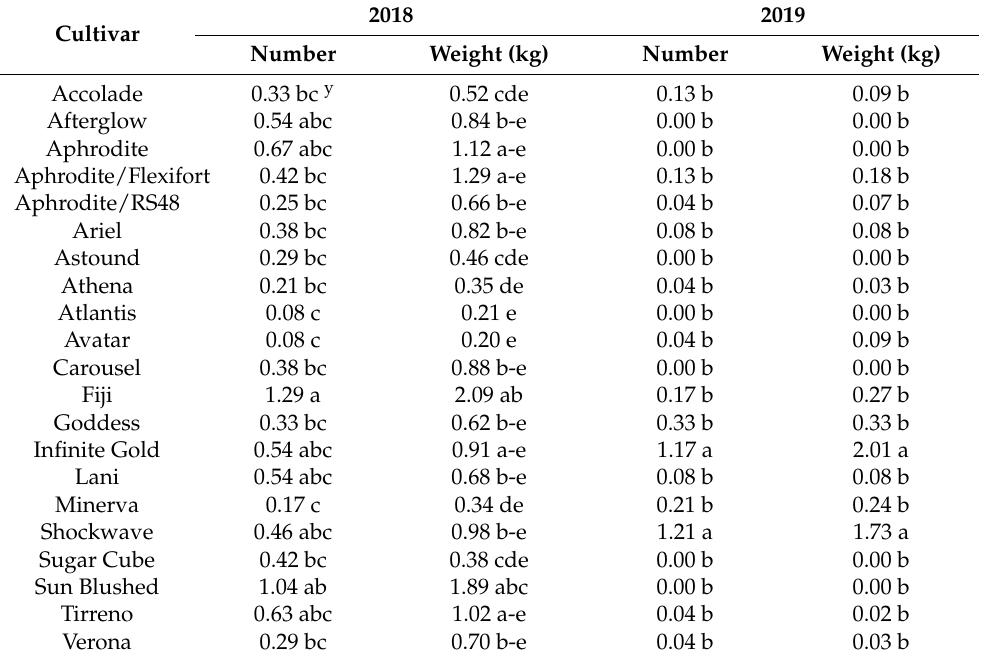
Table 4. Mean unmarketable fruit number z and weight per plant of 20 muskmelon cultivars and two grafted entries evaluated in western Pennsylvania in 2018 and